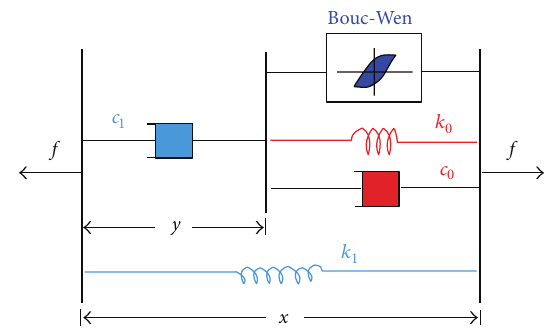
Figure 4: Mechanical model of the MR